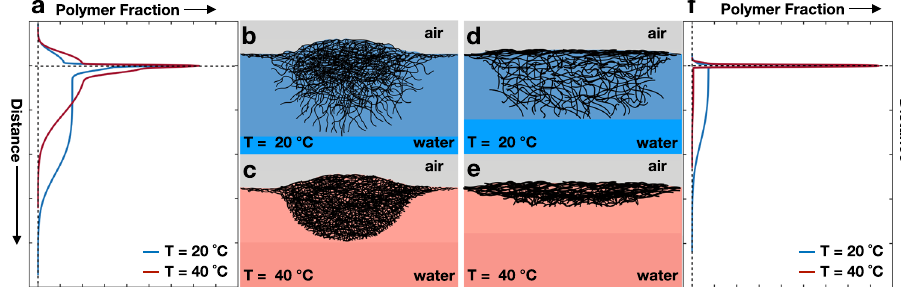
Fig. 3 Sketch of the adsorbed microgels. a The vertical pro fi les of standard microgels and f the vertical pro fi les of ULC microgels below and above the VPTT. Their corresponding shapes are outlined in b – e . The shapes are based on the combination of our polymer fraction pro fi les, simulations and AFM measurements at the liquid-solid interface from the literature 25